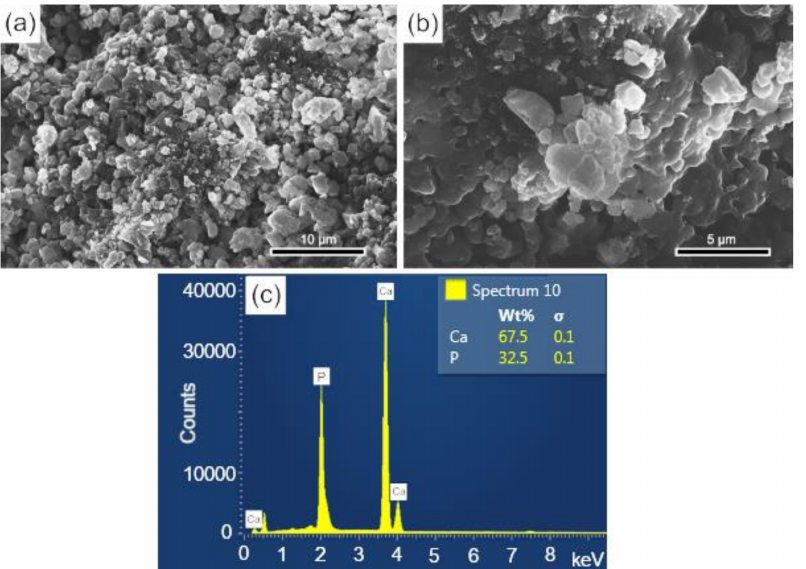
Figure 7. SEM images of the scaffold surface (control-BCP) sintered at 1100 ◦ C for 2 h, before immersion in SBF: ( a , b ) morphology and microstructure of the surface and ( c ) EDS obtained on the sample surface. Ca = calcium; P = phosphorus; %wt = mass fraction; σ = mean deviation.